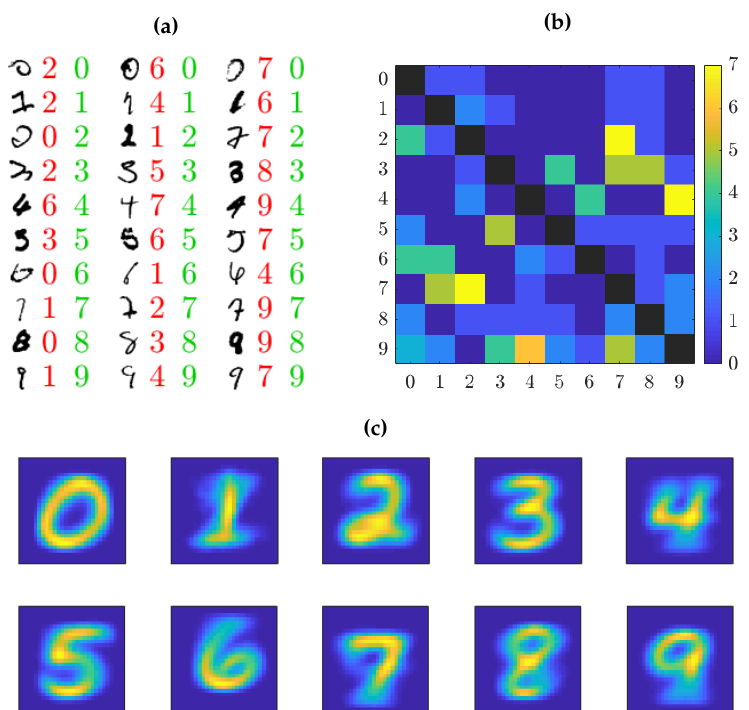
Figure 6. MNIST classification: ( a ) Images misclassified by kernel-based MANDy described in Section 3.2. The original image is shown in black, the identified label in red, and the correct label in green. ( b ) Histograms illustrating which categories are misclassified most often. The rows represent the correct labels of the misclassified image and the columns the detected labels. ( c ) Visualizations of the learned classifiers showing a heat map of the classification function obtained by applying it to images that differ in one